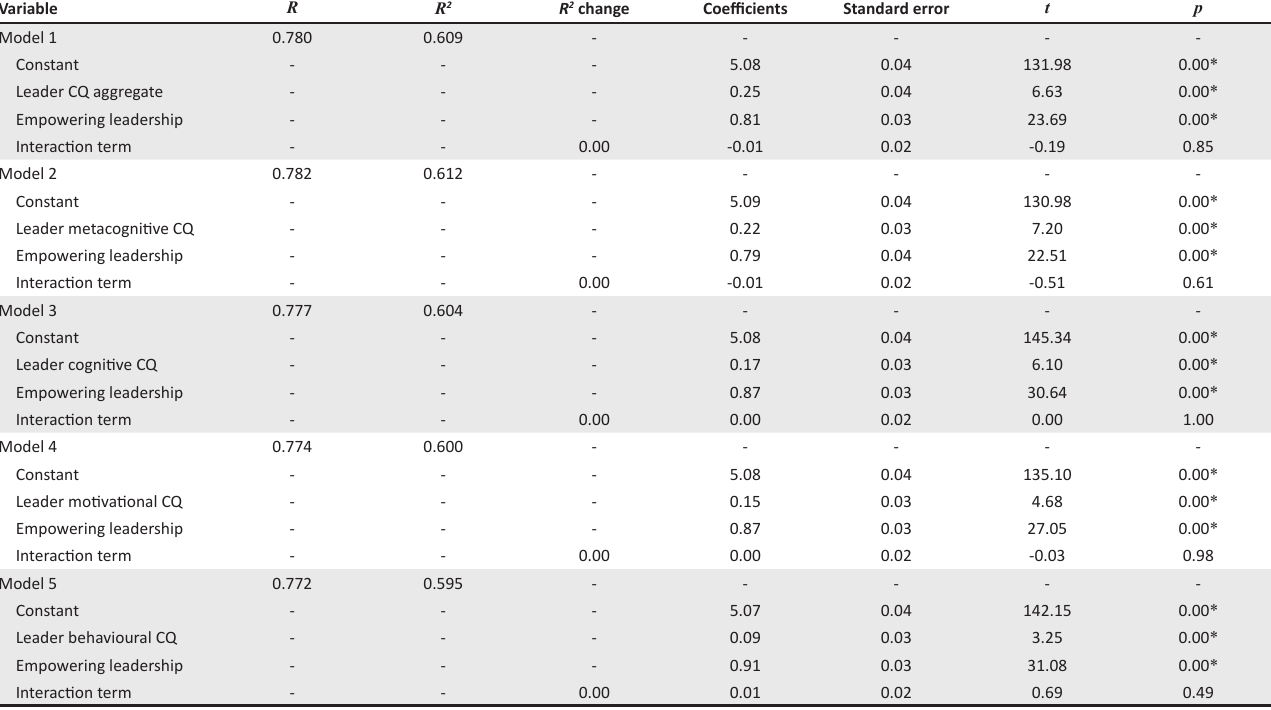
TABLE 7: Moderated multiple regression – Empowering leadership and leadership